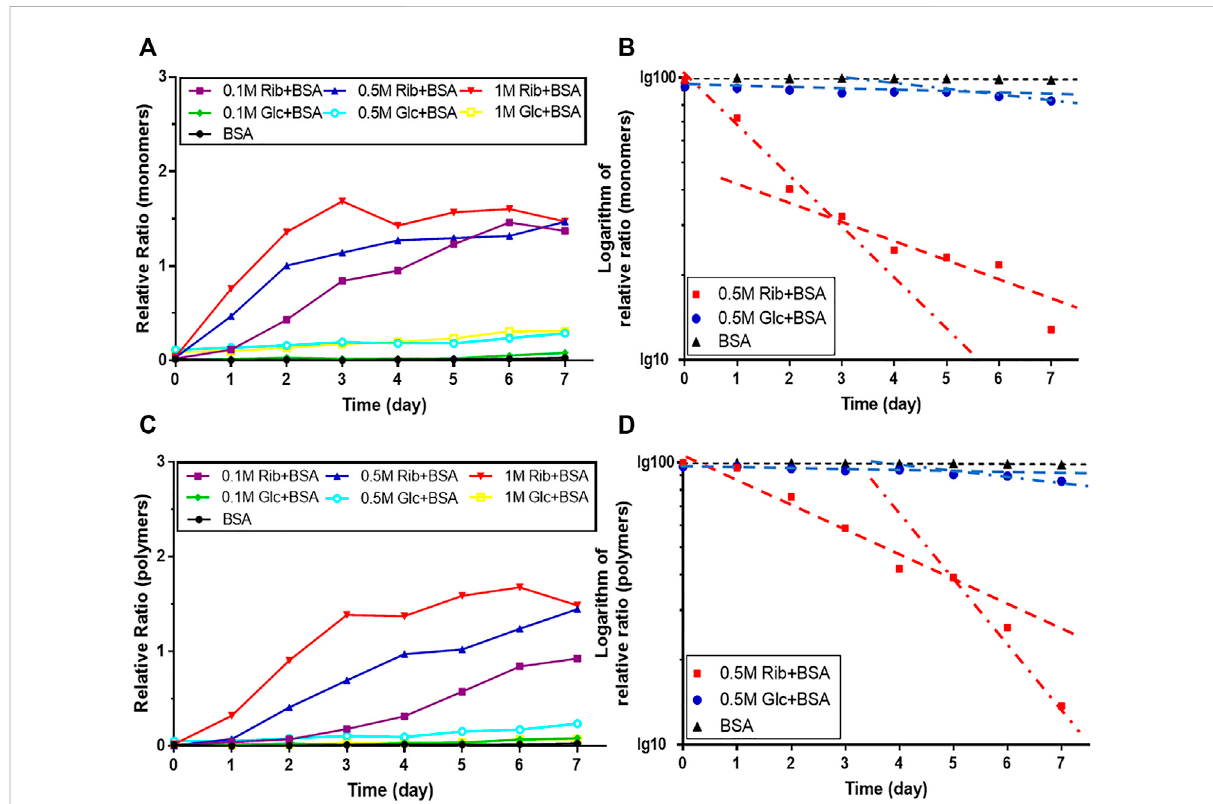
FIGURE 2 KineticchangesinAGEsaftertheincubationofBSAwithribose.Thesamedata(BSAincubatedwith0.5 Mriboseor0.5 Mglucose)fromFigure1 were analyzed by Tsou ’ s method. Blotting densities of monomers are shown in (A) , and data were plotted in semi-logarithmic coordinates (B) . Blotting densities of polymers are shown in (C) , and data were plotted in semi-logarithmic coordinates (D) .